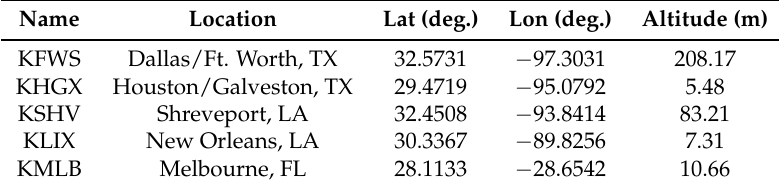
Table 1. NEXRAD radar stations’ name, location, and altitude